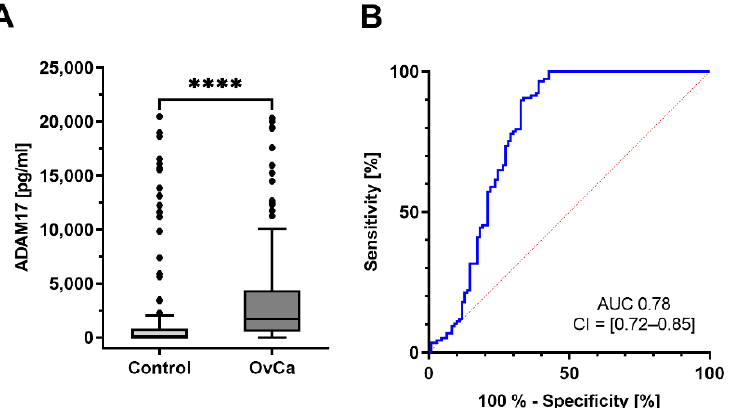
Figure 3. ( A ): Significant difference of ADAM17 blood levels between patient cohort and